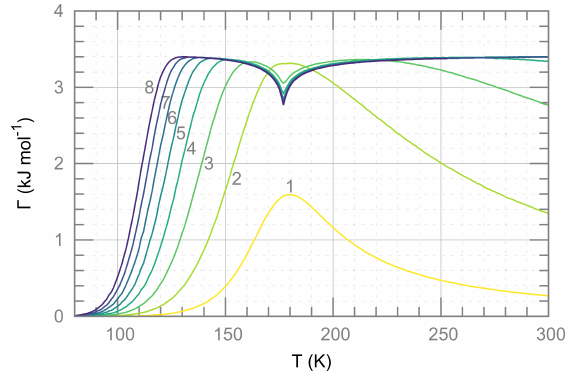
Figure 4. Temperature-dependent estimates for Γ obtained from a combination of enthalpies calculated with PBE (see Table 1) and MC simulations for supercells of size n × n × n with values of n (1 to 8) as indicated in the